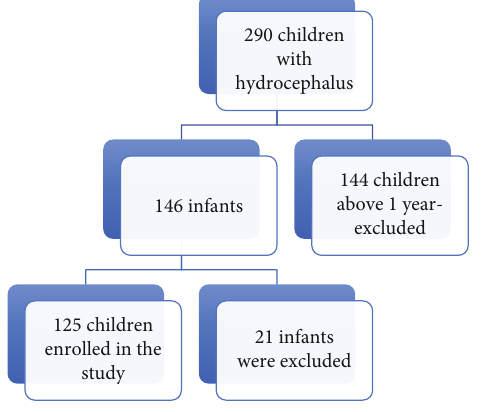
Figure 1: Study enrolment.